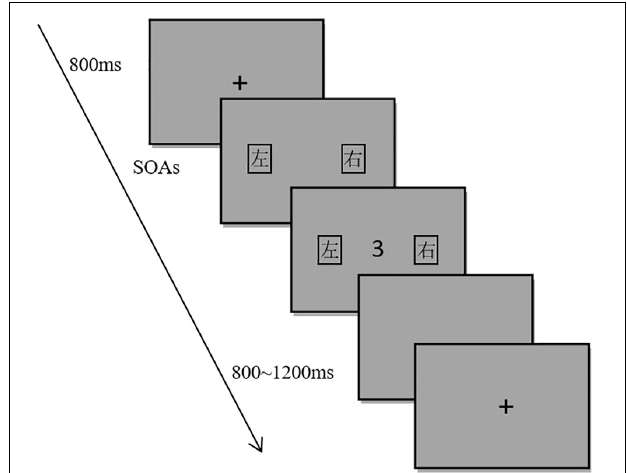
FIGURE 2 | Flow chart of Experimental